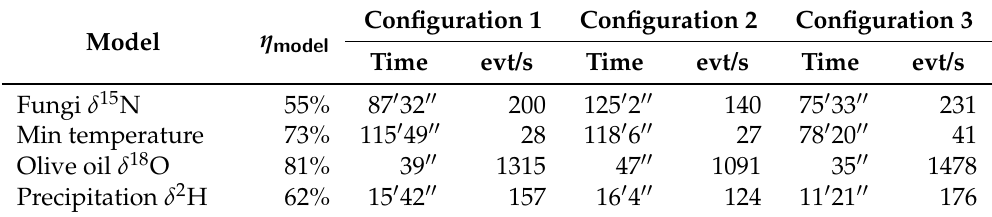
Table 4. Model performances, measured in target events per second. η model (17) is expressed in percent, running times in minute